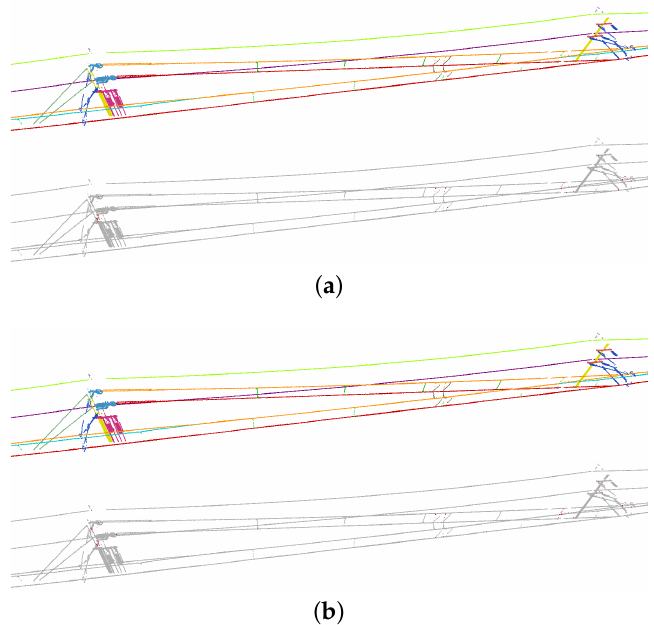
Figure 10. Segmentation results of insulated overlap section: ( a ) unidirectional mode; and ( b ) bidirectional